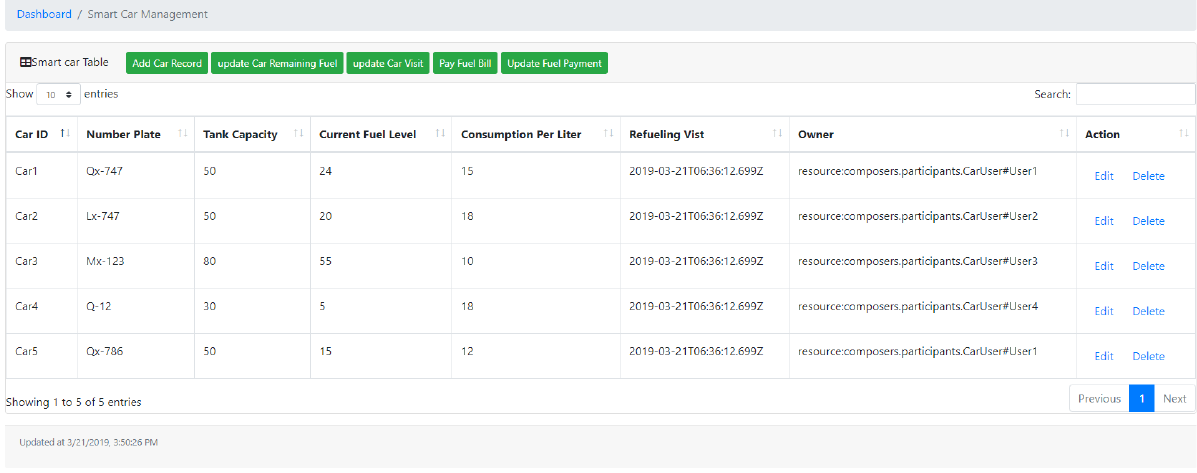
Figure 13. Smart car management